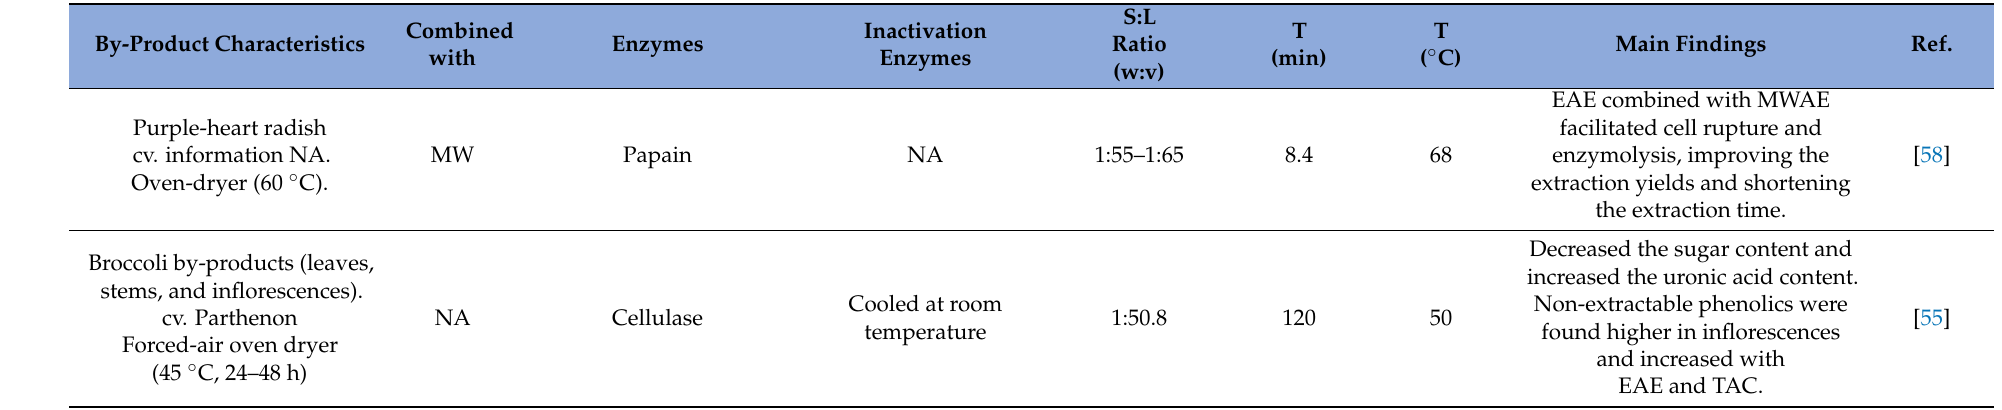
Table 3. Enzymatic conditions (enzyme, pressure, time, and temperature) for the extraction of bioactive compounds from Brassica